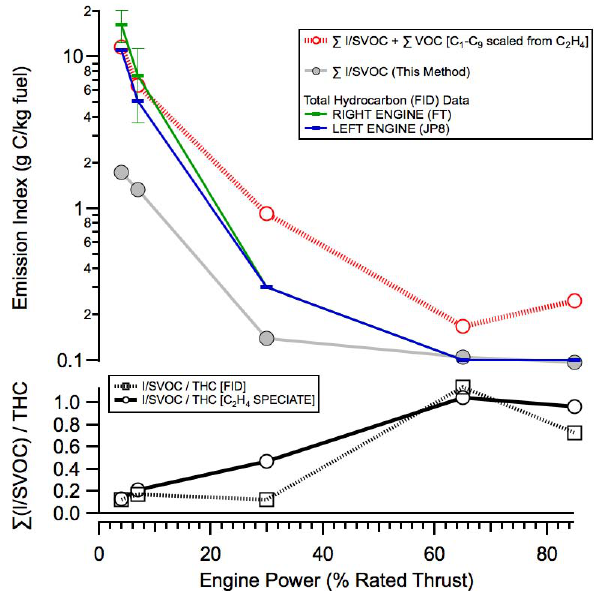
Fig. 6. Emissions of I/SVOCs as a function of engine power. Upper panel: power-dependent emission indices of I/SVOCs (measured with the present method), THC (measured with FID at 1m) for each engine, and the sum of total VOCs (as estimated from mea- surements of C 2 H 4 using the SPECIATE inventory) and I/SVOCs as a function of engine power. Lower panel: power-dependent ra- tios of measured I/SVOCs to total organic emissions. Two ratios are displayed, one based on the measured THC values and a second estimate from the scaled C 2 H 4